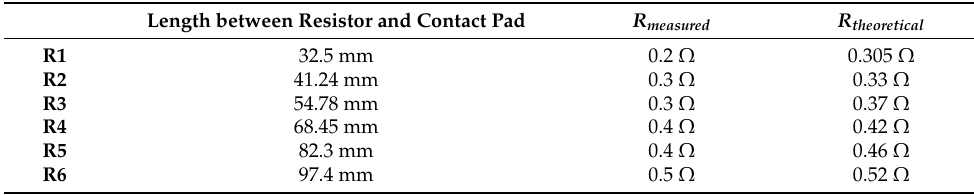
Table 5. Difference between R measured and R theoretical .